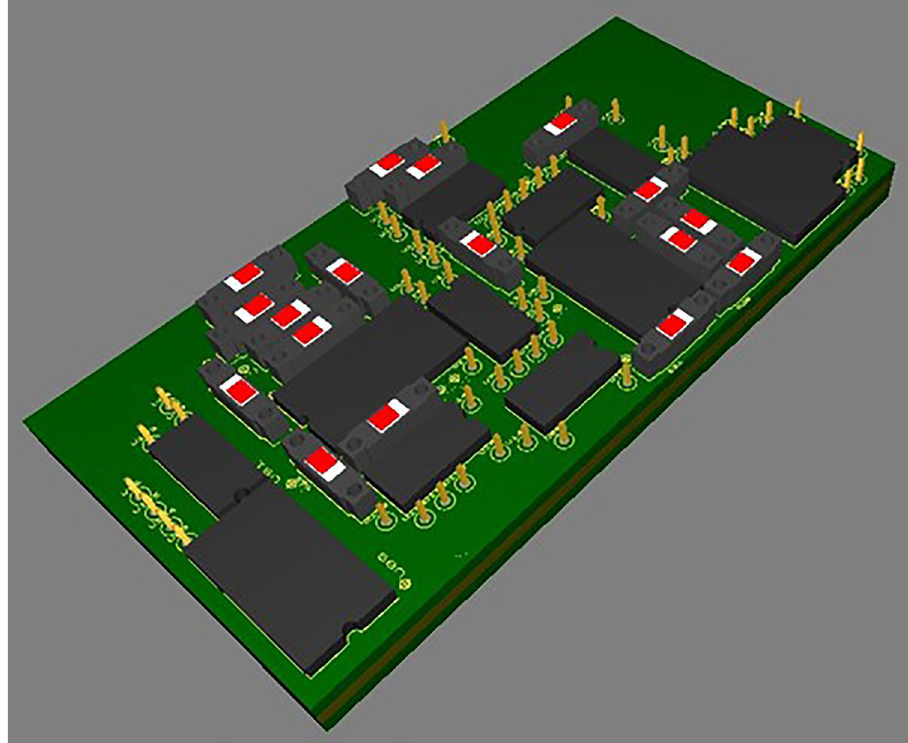
Figure 6. Layout model of parallel computing unit (top view). (Multisim https:// www. ni. com/ shop/ elect ronic- test- instr ument ation/ appli cation- softw are- for- elect ronic- test- and- instr ument ation- categ ory/ what- is- multi sim.